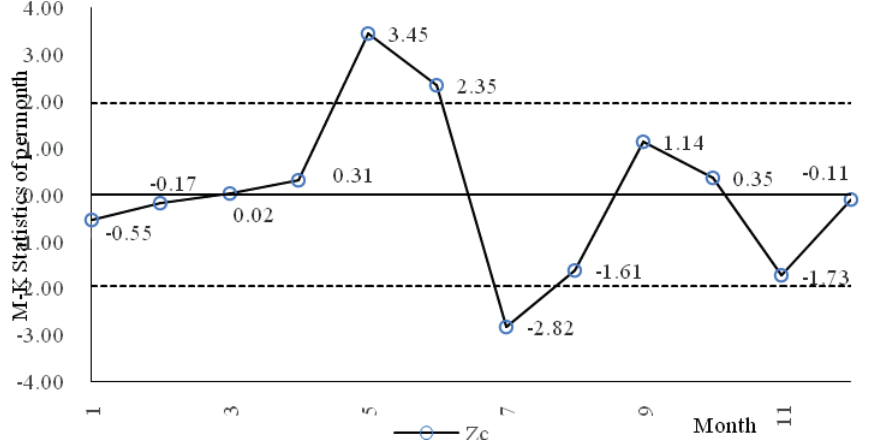
Fig. 3 M-K test of the proportion of the monthly precipitation in Haihe River